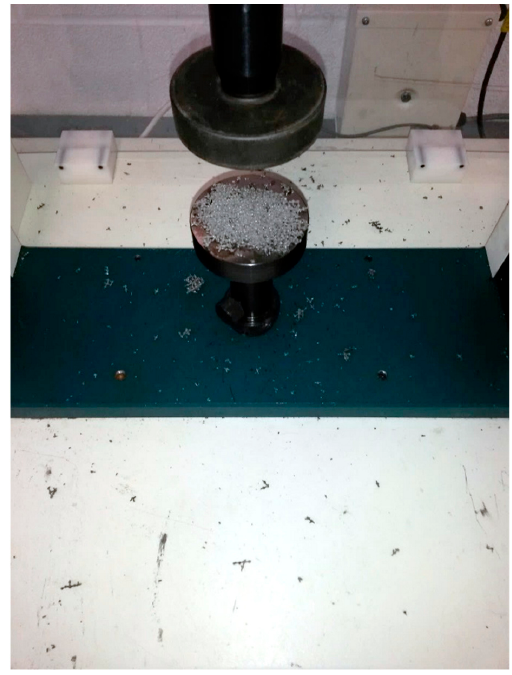
Table 8. Summary of Young’s moduli for the four lattice topologies from mechanical test results.